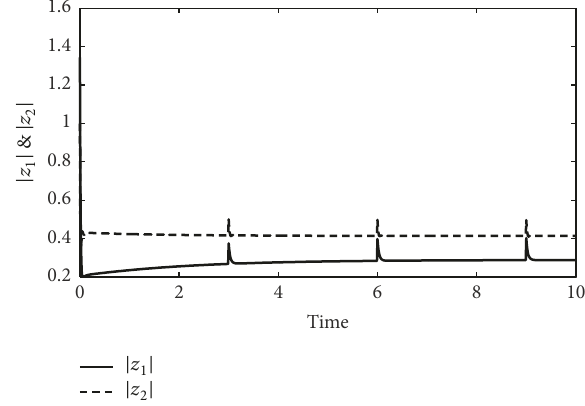
Figure 2: State curves of Im (𝑧 1 ) and Im (𝑧 2 ) with impulsive disturb- ances.